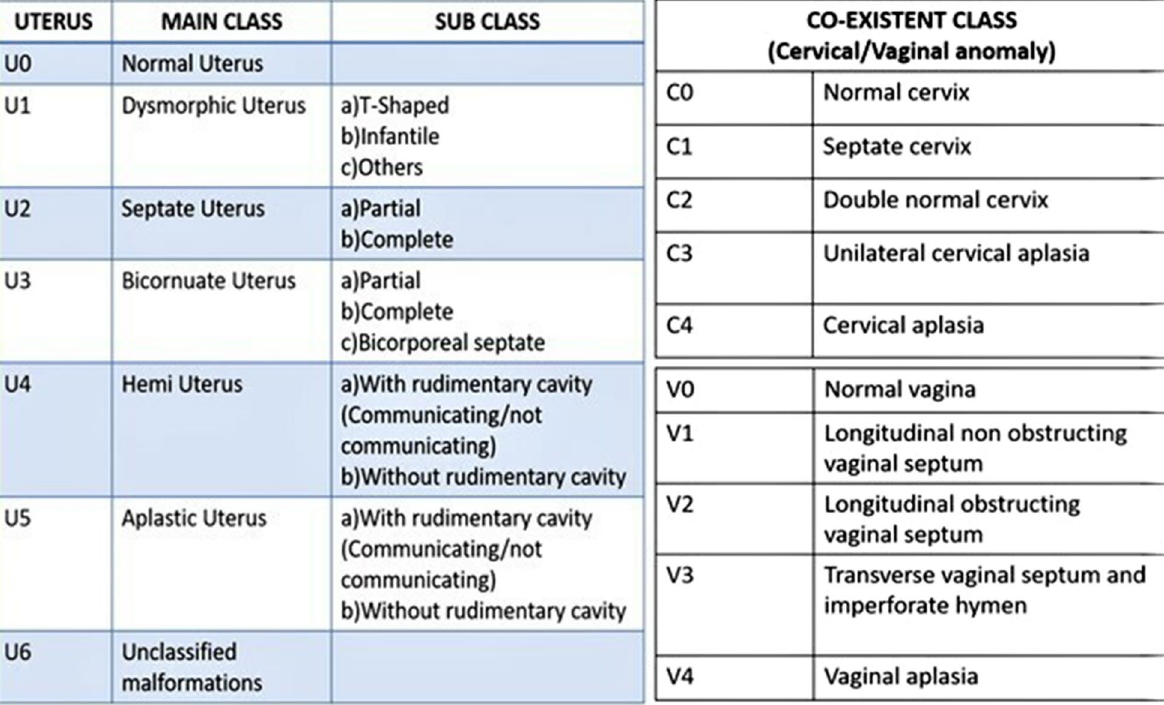
Fig. 1 European Society of Human Reproduction and Embryology and the European Society for Gynaecological Endoscopy (ESHRE/ESGE) consensus classification of Müllerian duct anomalies (Adapted from Reference